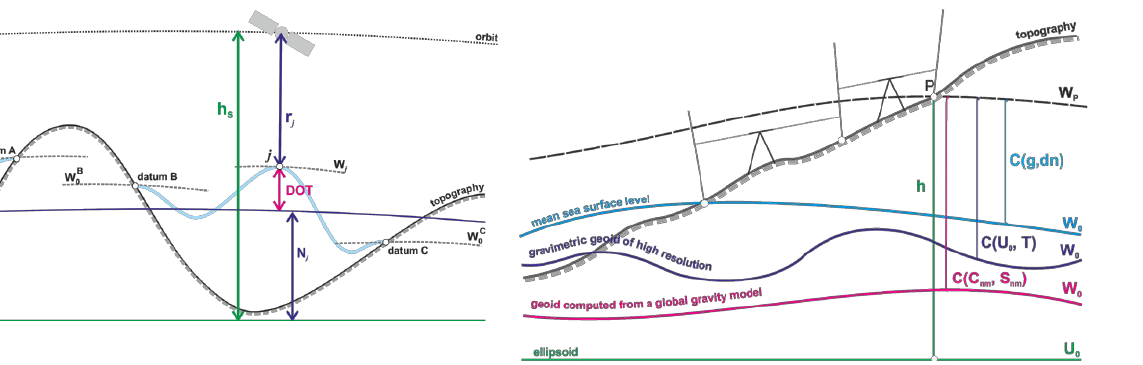
Figure 4. Dynamical ocean topography and local vertical datums.